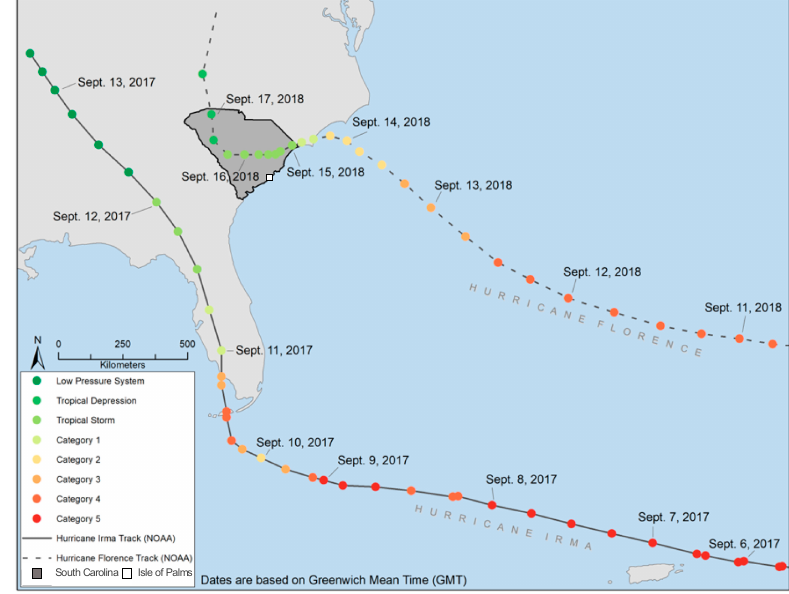
Figure 3. Hurricanes Irma and Florence path [46,47].